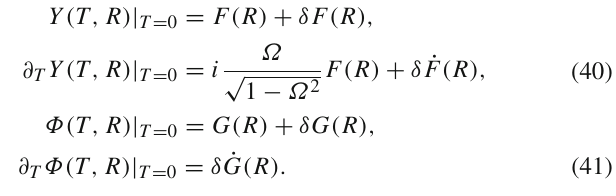
+ v 2 ( 0 ) + g 2 ( 0 ) = 1 (left plot) and γ(ω) dependence (right m 2 m 2 m 2